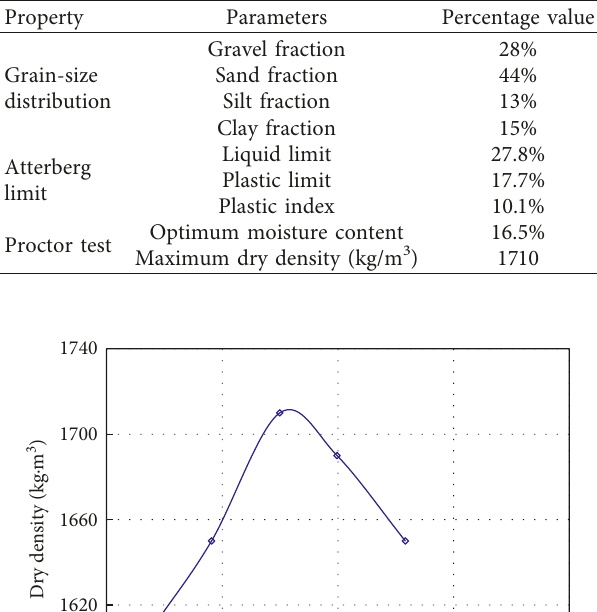
Table 1: Summary of soil properties.